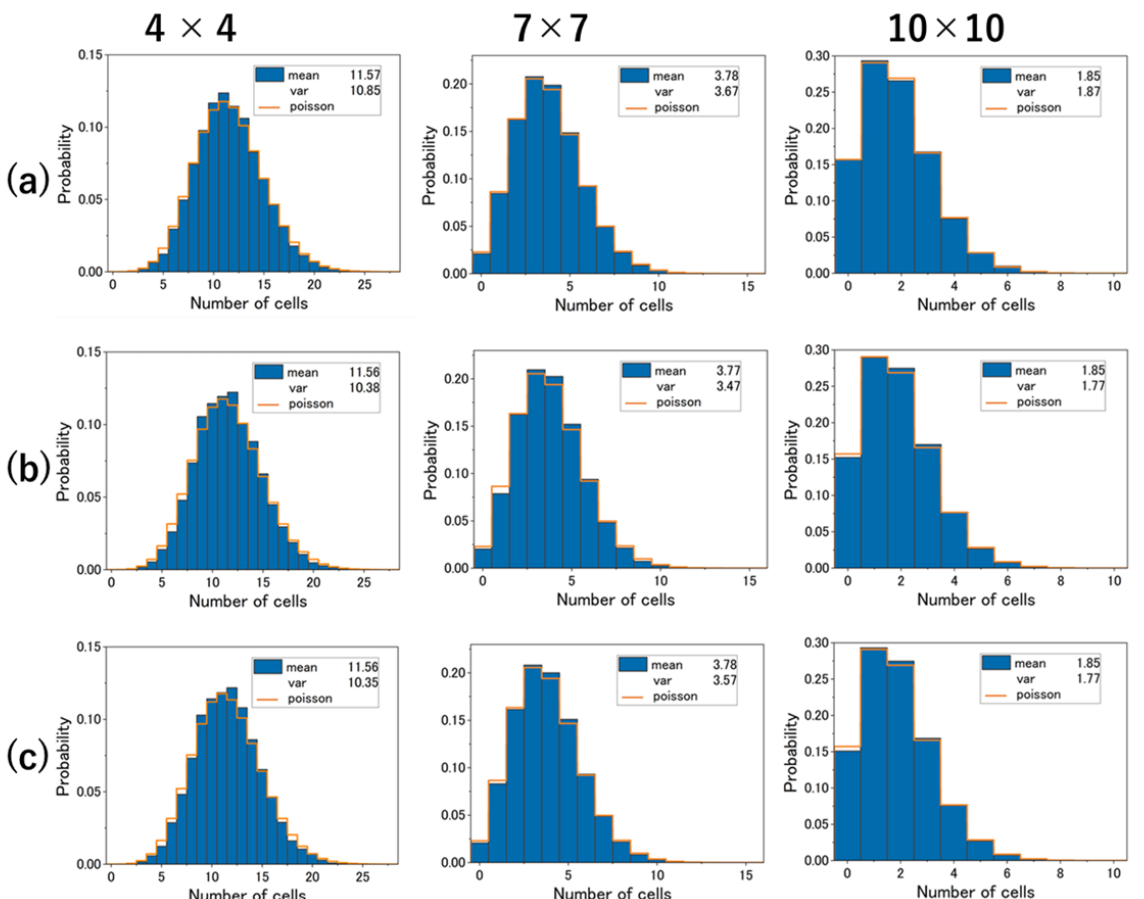
Figure 5. Histograms in m × m ( m = 4,7, 10). ( a ) Histograms in the experimental results. The period between 35 and 50 min from the beginning of the observation was analyzed. The video used for the analysis was thinned to 1 fps, and the total number of frames was 900. The average number of cells was 185.18 per frame. ( b ) Cell distribution by MCS with observed SC placed. The simulation was performed with a total number of 185 cells in each frame, which was the sum of the SC and the cells at randomly generated coordinates. The diameter of the cells was set to 10 µ m and they were arranged so that they did not overlap. This was performed from frame 1 to frame 900. ( c ) The coordinates of all 185 cells were generated randomly. As mentioned above, the EV effect was also taken into account. This was repeated 900 times to generate a